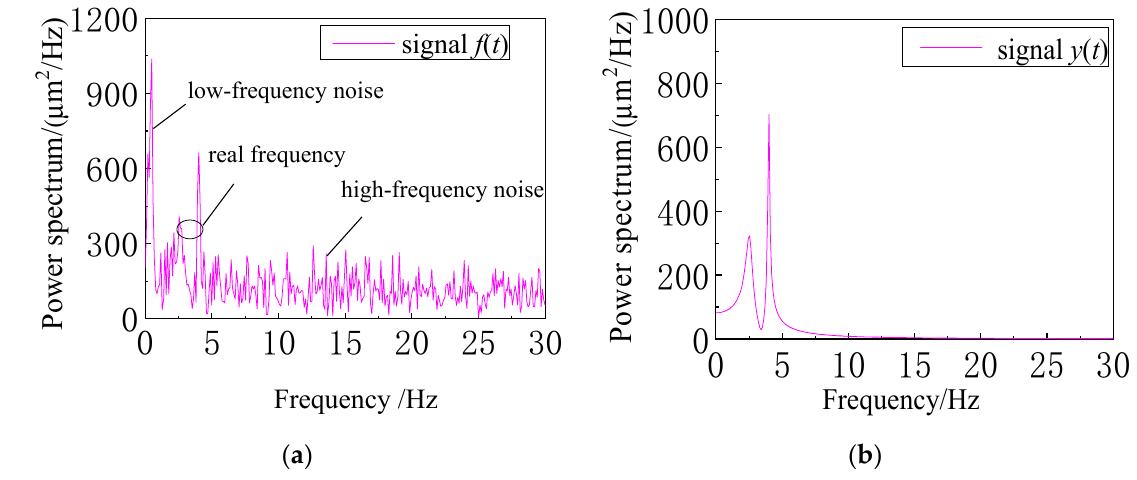
Figure 3. Power-spectrum comparison of noised signal f ( t ) and pure signal y ( t ) . ( a ) Power spectrum of noised signal f ( t ) ; ( b ) Power spectrum of pure signal y ( t ) .